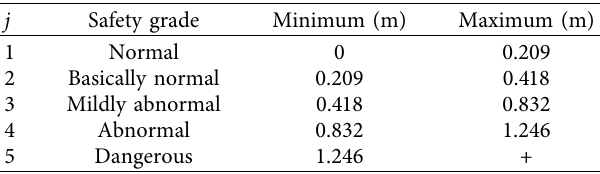
Table 5: The safety grade classification of sedimentation height of bottom outlet stilling